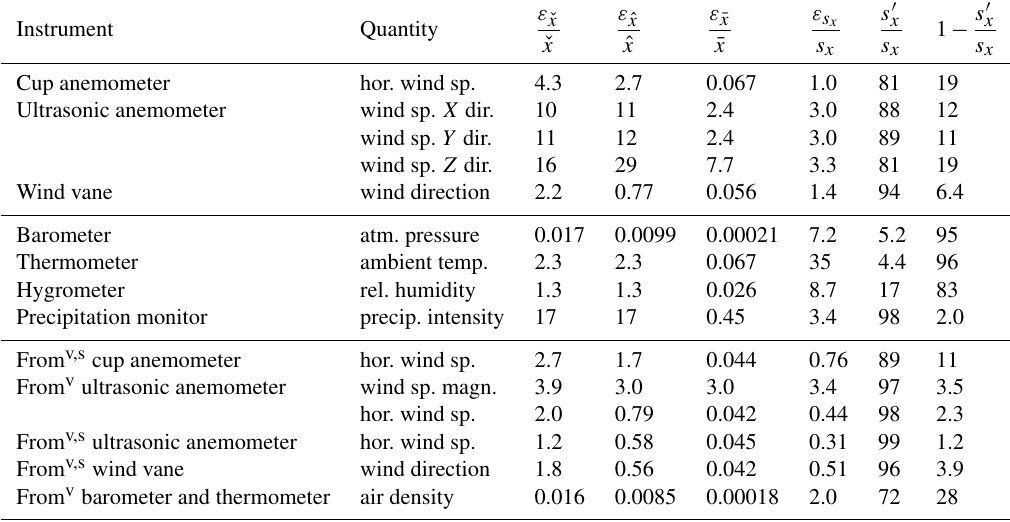
Table 3. Average relative uncertainties and bias in percent for quantities from the MMIJ dataset for which some (likely incomplete) uncer- tainty information is available. (See Table A1 for more information about the quantities. The values are given with two digits, but it is not implied that both are